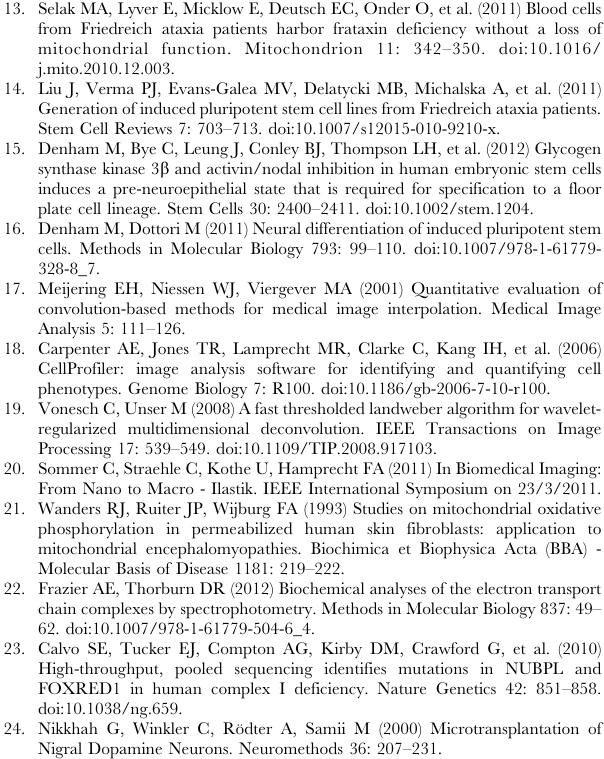
Figure S1 Mitochondrial membrane potential in FA iPS- derived neurons. ( A ) The DY m was assessed by microscopy in dissociated neurospheres plated as a monolayer by measuring the accumulation of the cationic dye TMRM in the mitochondrial rich peri-nuclear region. Greater then 80 cells from a single dish pre-incubation and post-incubation with the protonophore FCCP were analysed with representative images in ( B) . Figure S2 Indicative images for TUNEL staining, and post image acquisition analysis in FA iPS-derived neurons. Indicative images are shown for the TUNEL assay depicting: the TUNEL stain; DAPI stain; the ‘nuclei’ mask that is generated from the DAPI stained image; and the merged ‘nuclei’ and TUNEL